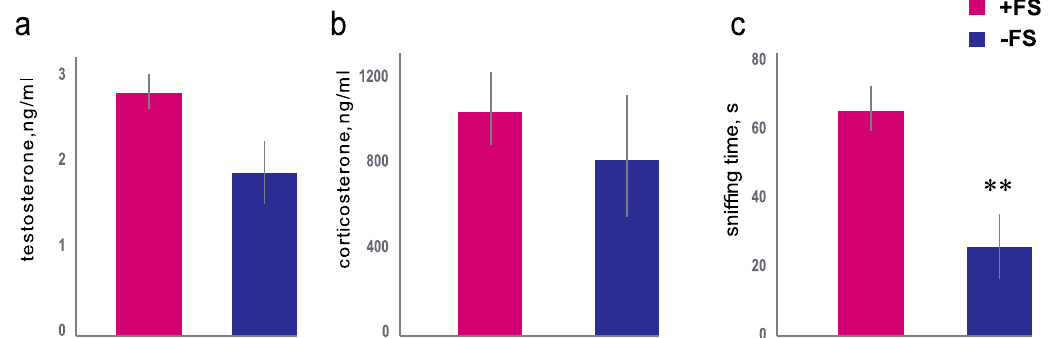
Figure 1. Behavioral and endocrine responses of male mice to SPF female scent. ( a ) The testosterone level (ng/mL) in the blood of the males in +FS group (group of males received bedding of females) (red column) or in − FS group (group isolated from female scent) (blue column). ( b ) The corticosterone level (ng/mL) in the blood of males in +FS group (red column) or in − FS group (blue column). ( c ) Frequency of sniffing of +FS group (red column) or − FS group (blue column) **- p < 0.01 Mann–Whitney U-test. Data are presented as the mean ± standard error.